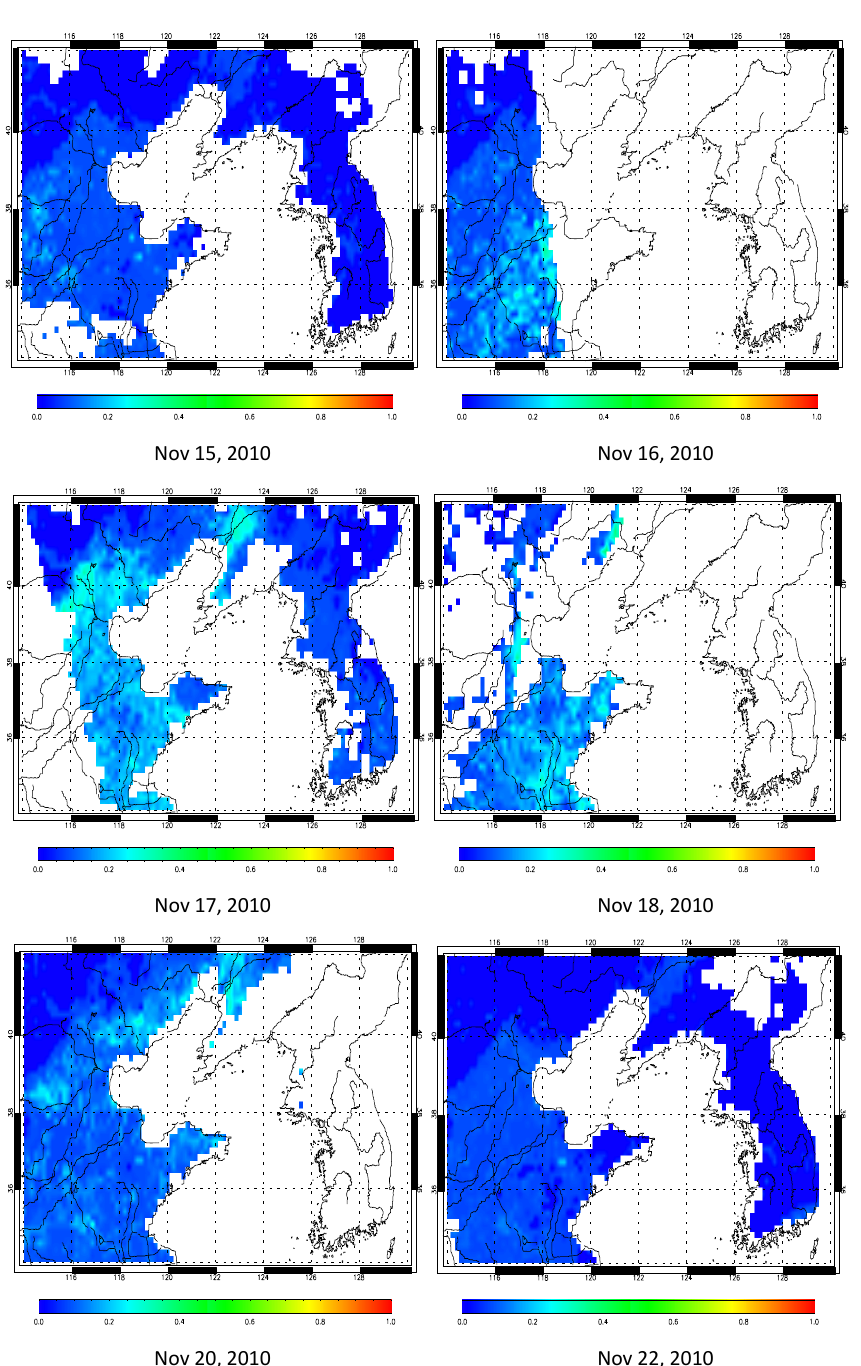
Fig.12. Aerosol optical depth contributed by fine mode (Fine AOD) over East Asia during December 15-22, 2010, except for November 19, and November 21 due to cloud contaminated.